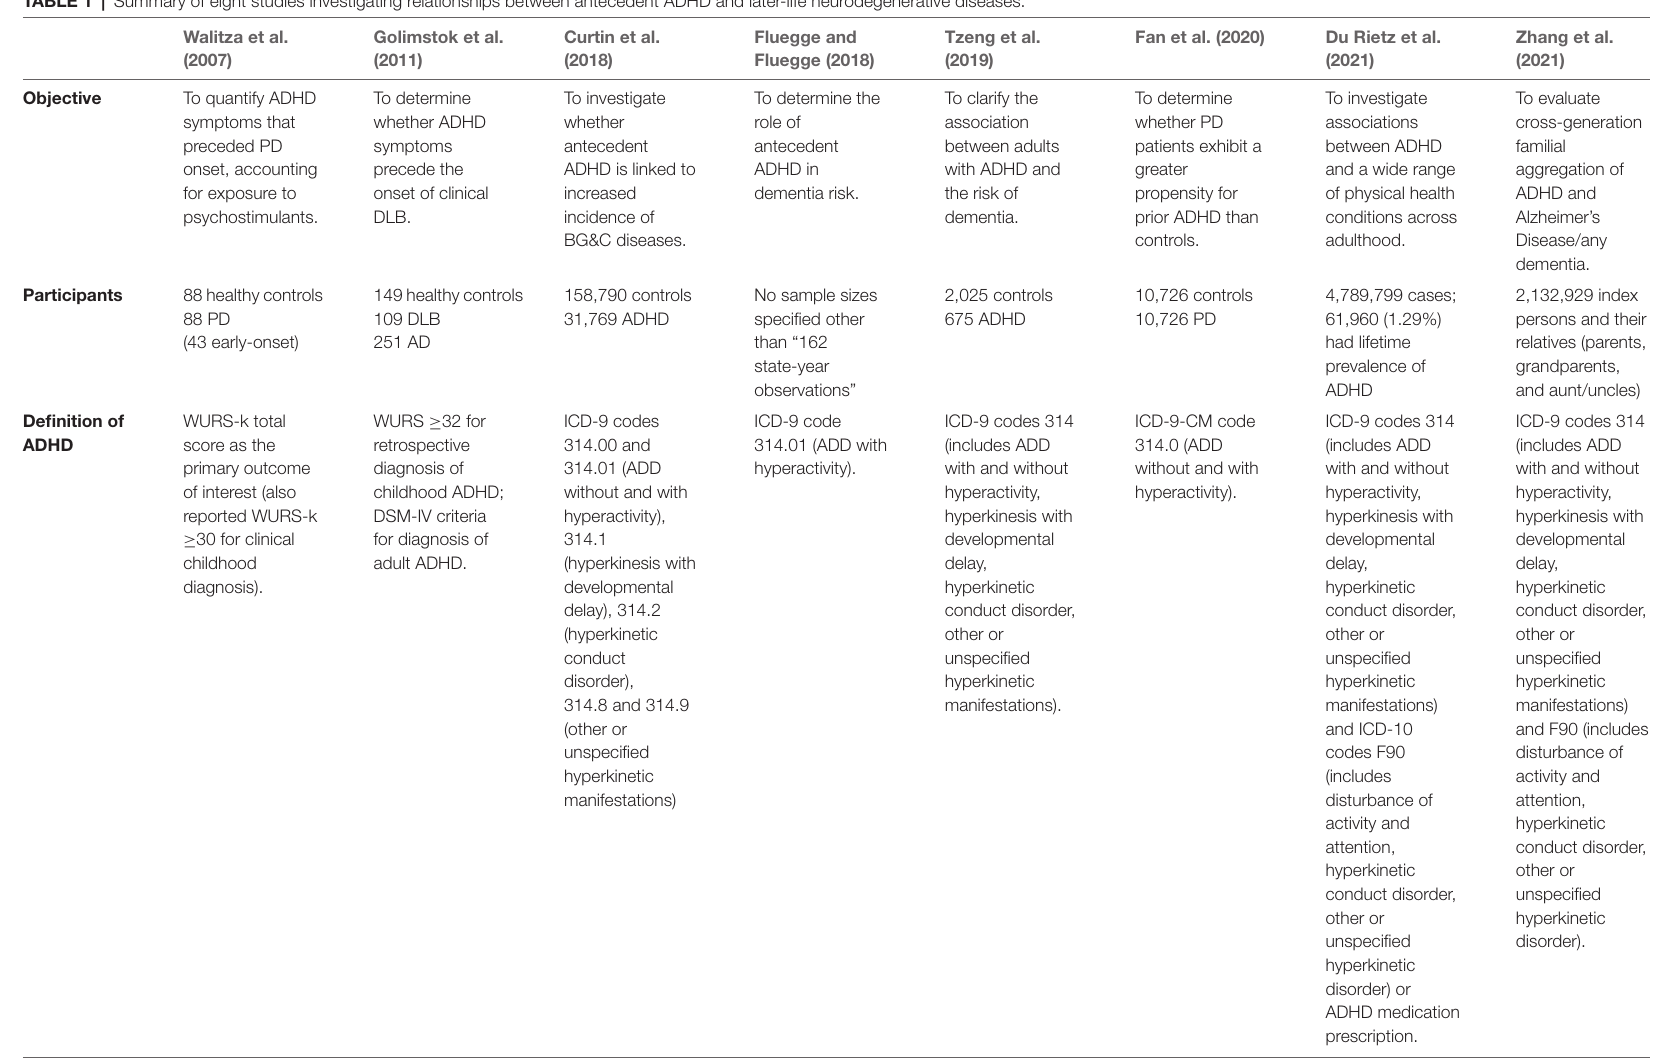
TABLE 1 | Summary of eight studies investigating relationships between antecedent ADHD and later-life neurodegenerative diseases. Walitza et al.